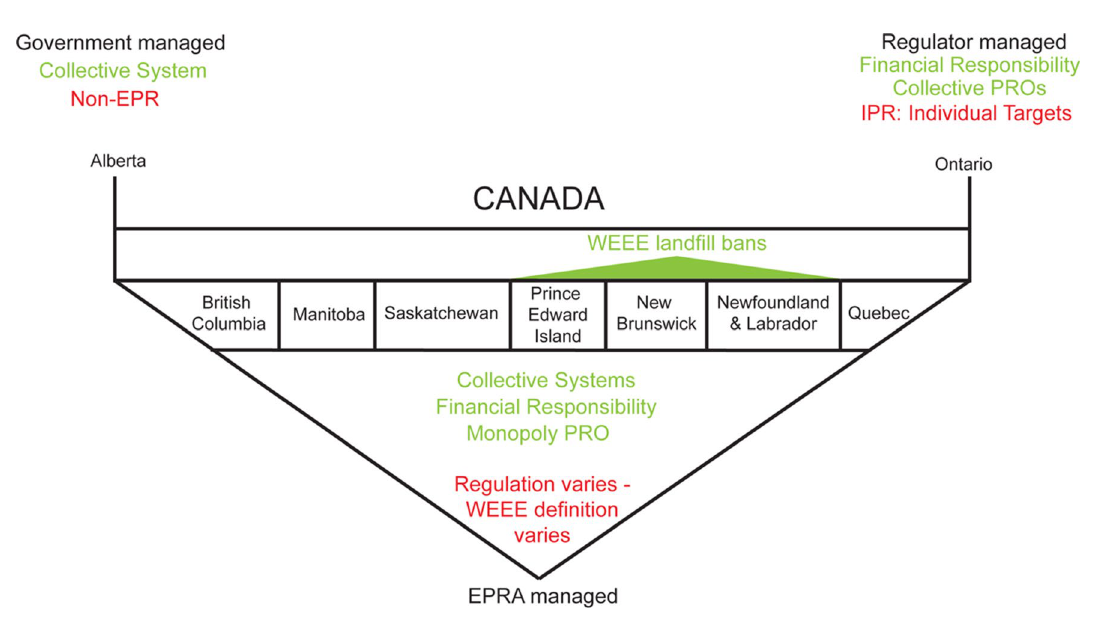
Fig. 2 Relevant WEEE regulation systems: Canada—synthesized by